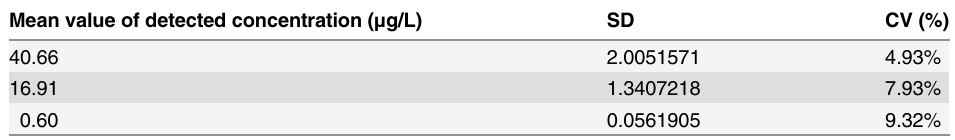
Table 4. Analytical precision of determination of HBsAg in human serum (n = 20).